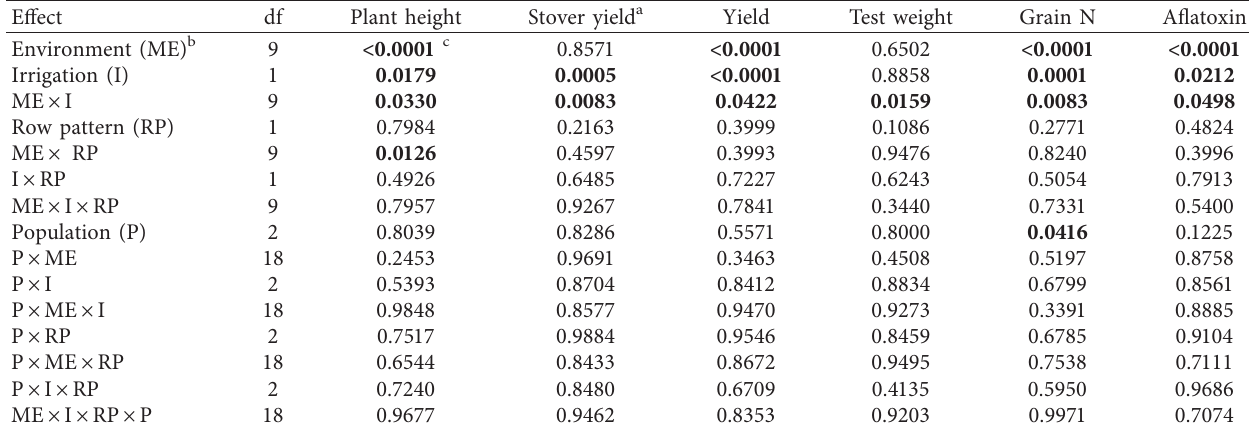
Table 5: P values from a general linear mixed model analysis for specific treatments over five site-years during the 2011 to 2014 growing seasons across northern and central Alabama.